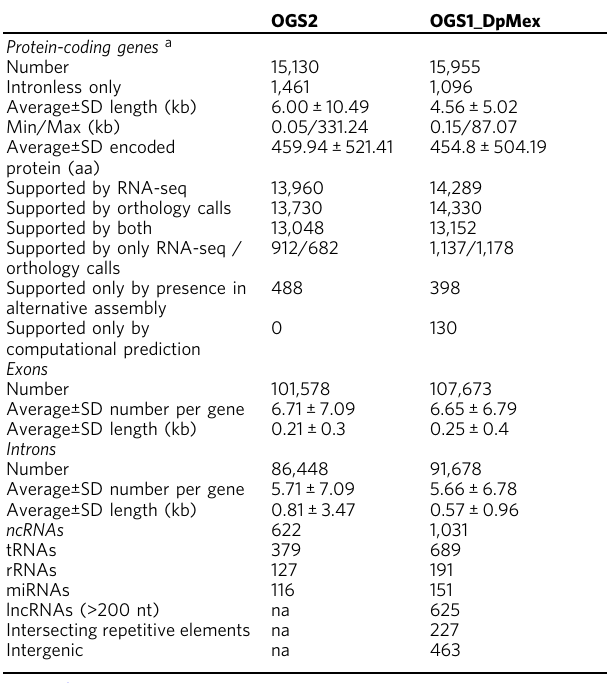
Table 2 Salient features of a previous and our gene annotation of D. plexippus